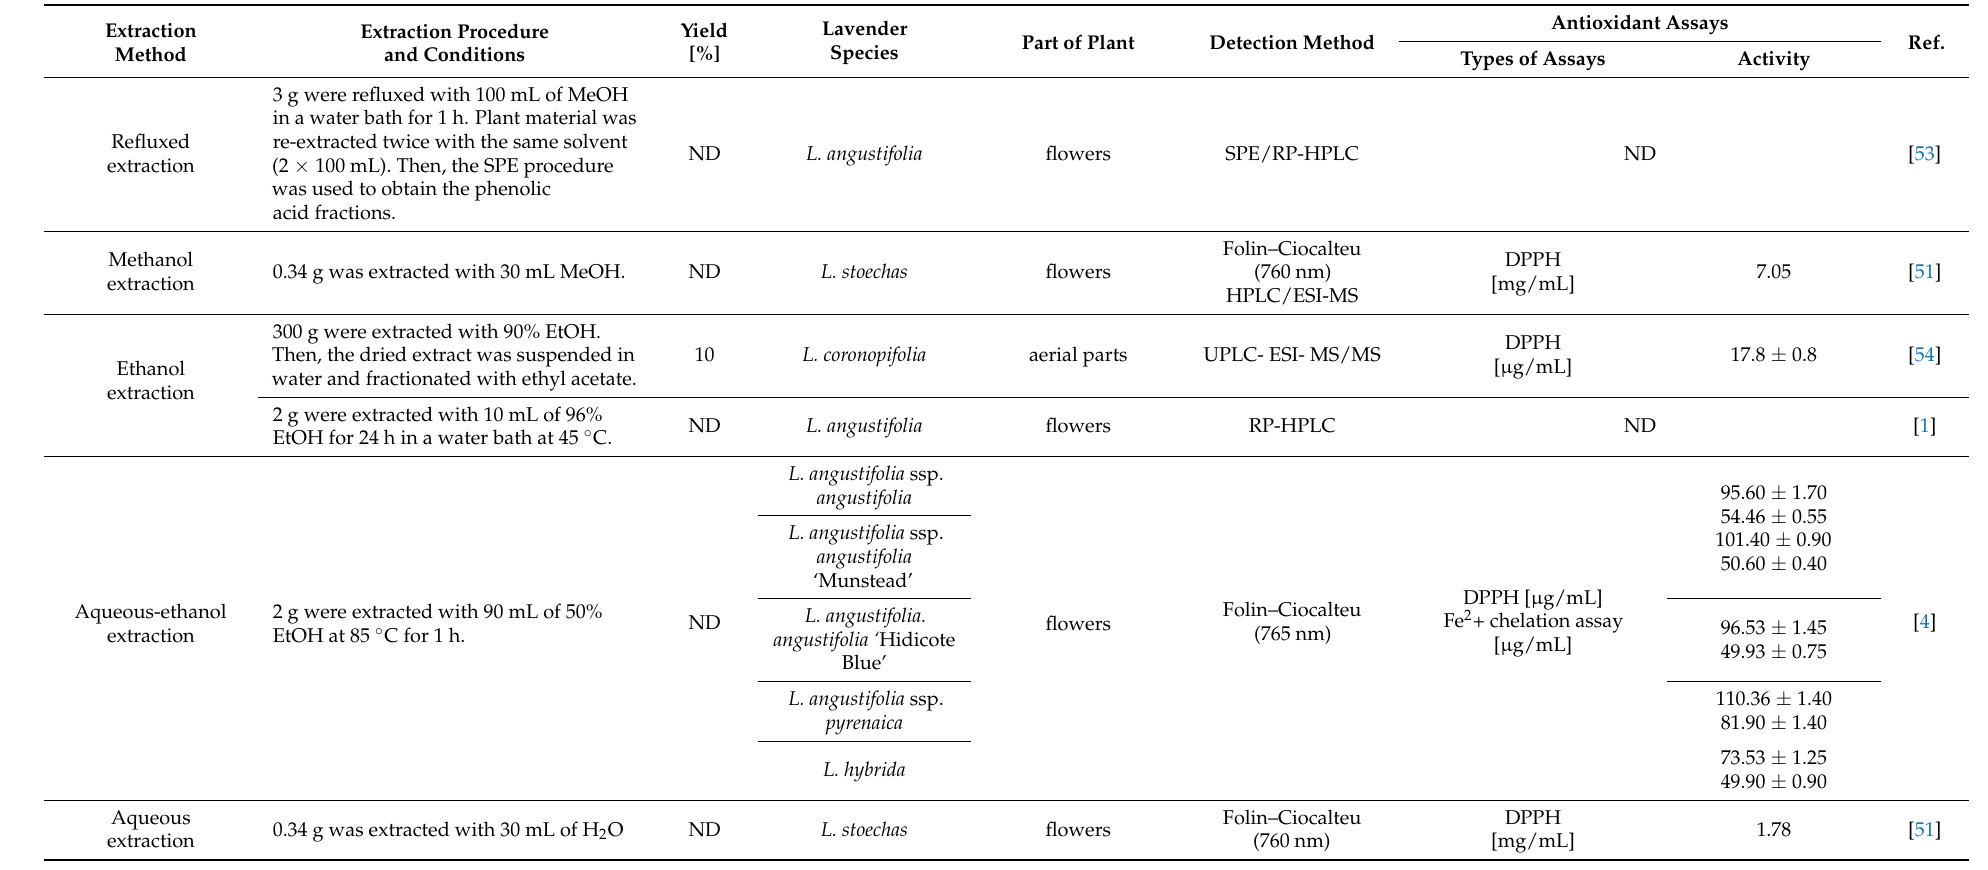
Table 2. Extraction techniques for various lavender